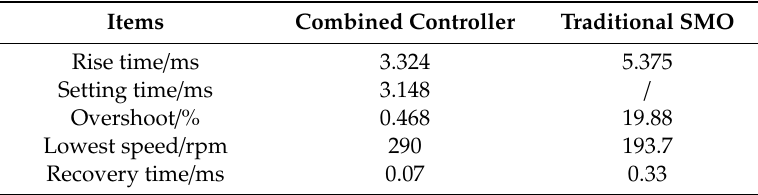
Table 2. Simulation comparison performance ( N r = 300 r /